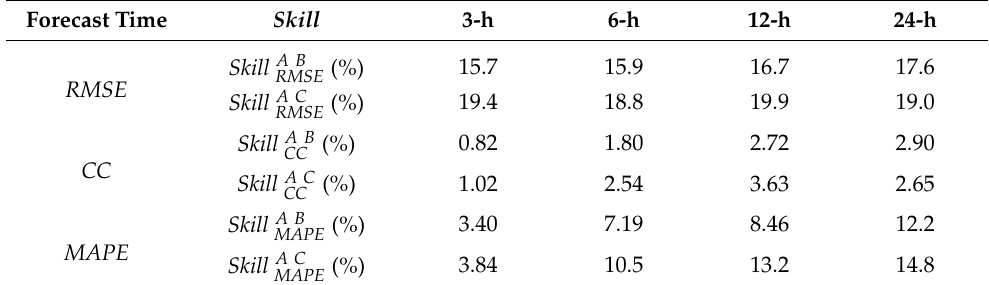
Table 2. Error indices improvement ( Skill ) of Model B and Model C relative to Model A. Forecast